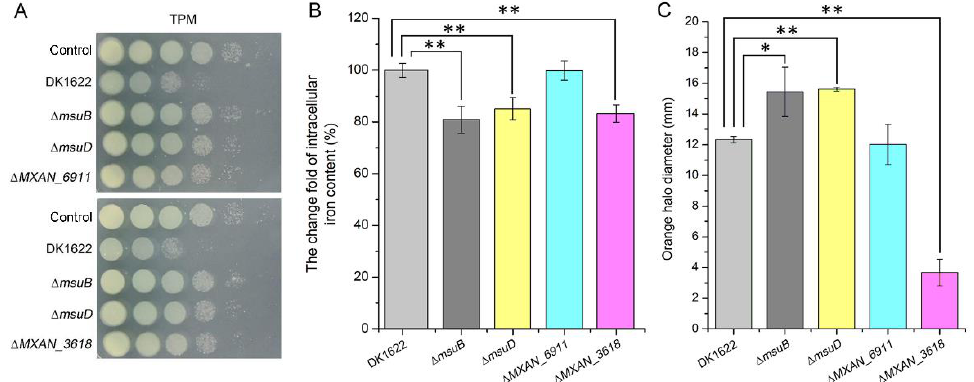
Figure 4. The effects of deleting siderophore synthesis and transport-related genes on intracellular iron levels, predation, and siderophore production. ( A ) The competition assay analyzed the predation of different mutants on TPM (1.5% agar) plates. After coculture of M. xanthus strains and PAO1 for 24 h, the cells were harvested and resuspended in 1 mL of MMC buffer. Subsequently, the cellular suspension was serially diluted in MMC buffer, and 3 µL of the suspension (from 10 −1 to 10 −6 ) was spotted on LB agar plates supplemented with tetracycline (20 µg mL −1 ) from left to right. The plates were grown at 37 °C and photographed after 24 h. ( B ) The relative content of intracellular iron was detected by the BPS method. ** p -value <0.01 compared with DK1622 as measured by a two-tailed unpaired Student’s t -test. ( C ) Determination of siderophore production by the chromeazurol S overlay (O-CAS) assay. * p -value <0.05 and ** p -value <0.01 compared with DK1622 as measured by a two-tailed unpaired Student’s t -test.